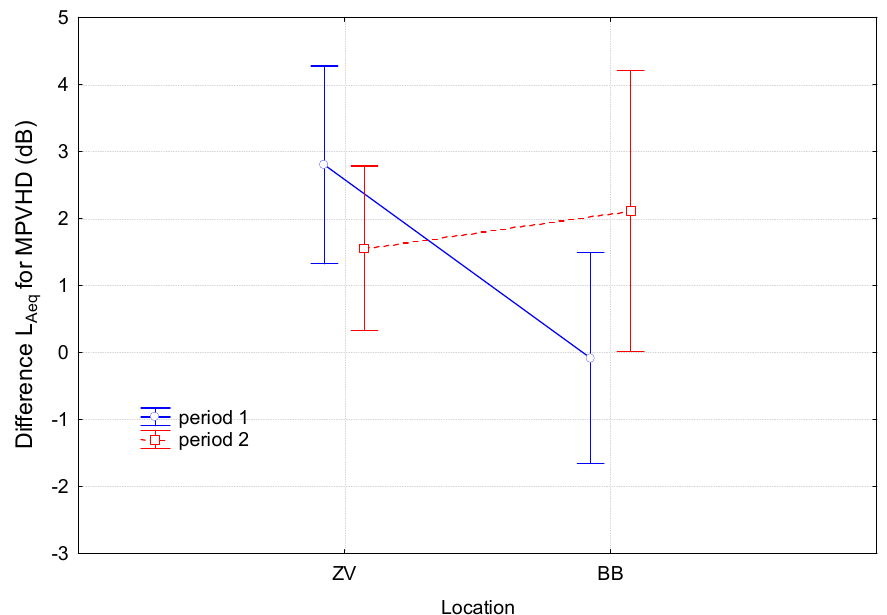
Figure 10. Graphical interpretation of the differences of the determining quantities obtained by MPVHD and the measurement depending on the location and time of the measurement.